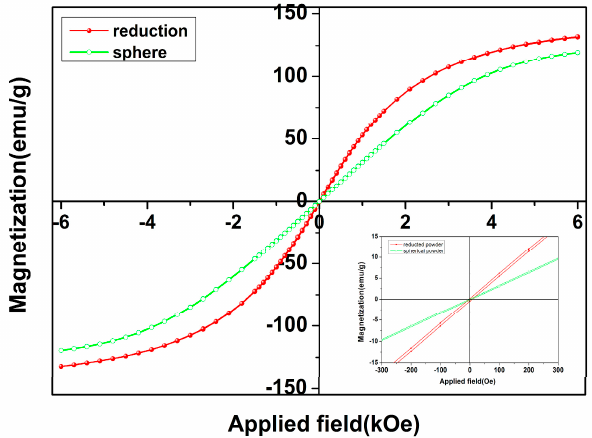
6 of 8 Figure 4 . XRD patterns: ( a ) Mixture metal oxides, ( b ) prealloy powder reduced at 973K and ( c ) spherical alloy powder fabricated at 1823 K, ( d ) particle size distribution of spherical Fe 50 Ni 50 alloy powder. Figure 4d shows the size-distribution of particle for spherical Fe 50 Ni 50 alloy powders annealing at 1823 K. The size distribution at 10%, 50% and 90% of the particles were represented using the volumetric diameters d 10 , d 50 and d 90 , respectively. The d 10 , d 50 and d 90 were smaller than the stated diameter. The size of d 50 was 20 µm for the as-fabricated spherical alloy powder, which agreed well with the SEM images. Similar to the conventional “solution solvent”, alumina powder presented a new “solid solvent” to some extent. Figure 5 shows the room temperature magnetic hysteresis loop of the pre-alloy and spherical Fe 50 Ni 50 alloy powders. The magnetic parameter can be obtained from the curves in Table 2. The